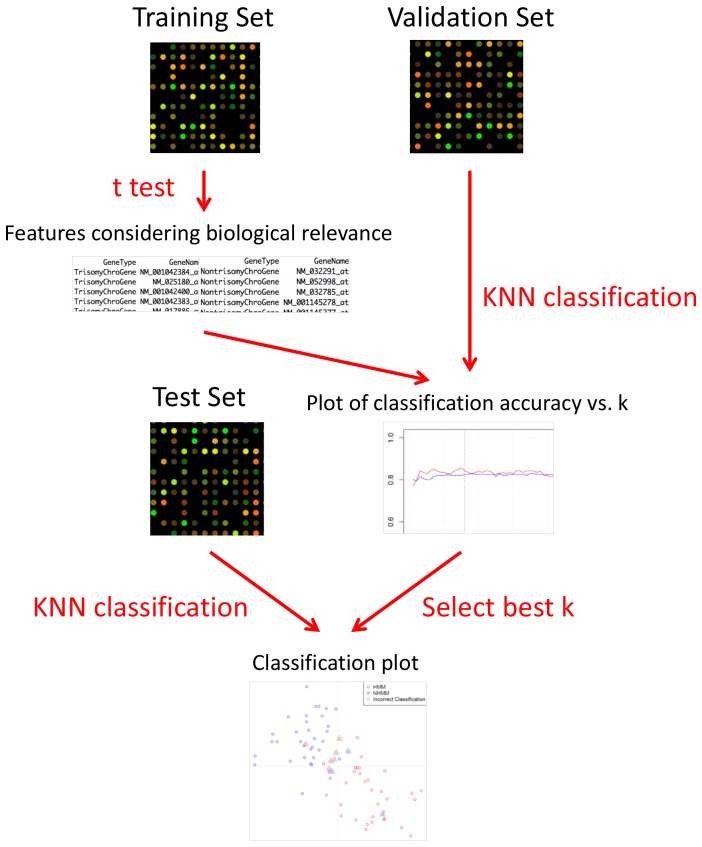
A general flowchart of the classification analysis steps.